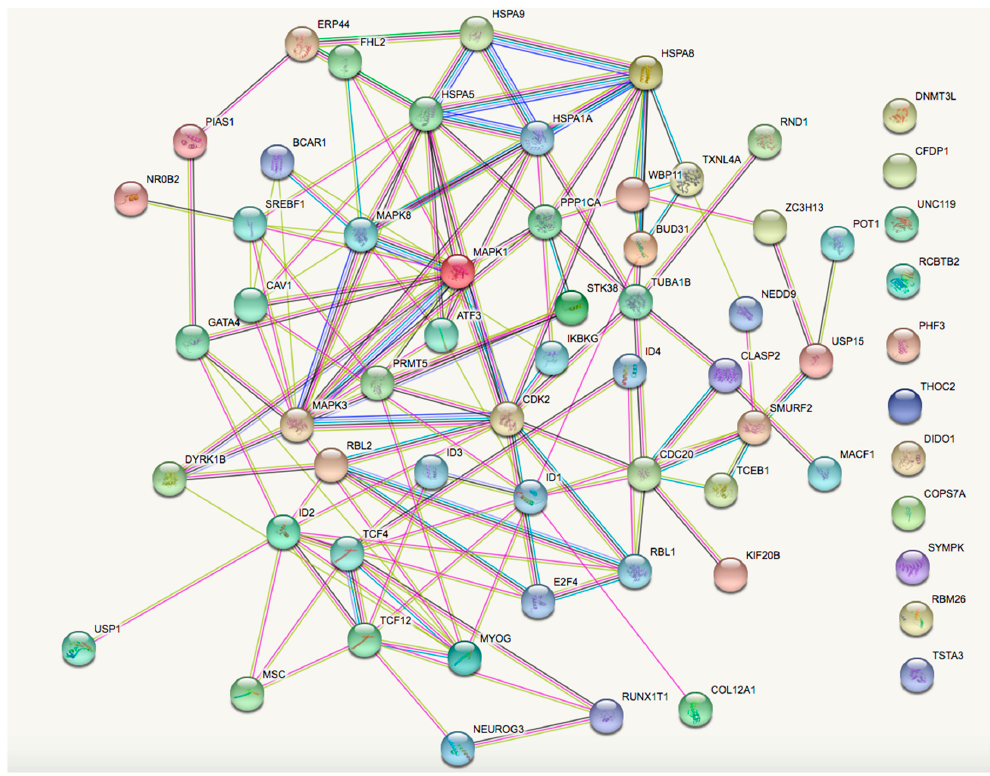
Figure 3. Gene network of 63 common interacting genes between EEDs, ID proteins, and neurocognitive disorders [66]. Table 2. Top five pathways with 63 common interacting genes with EEDs, ID, and neurocognitive disorders.